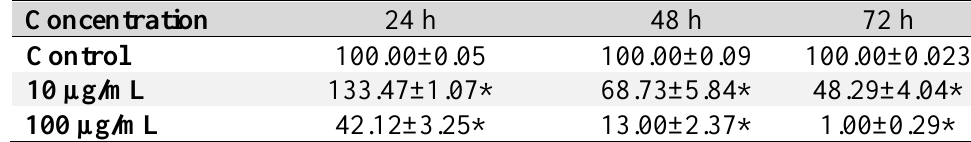
Table 3 . Antimigratory effect of O. minimum on HCT-116 colorectal carcinoma cells compared with control. The results are presented as the mean of two independent experiments ± standard